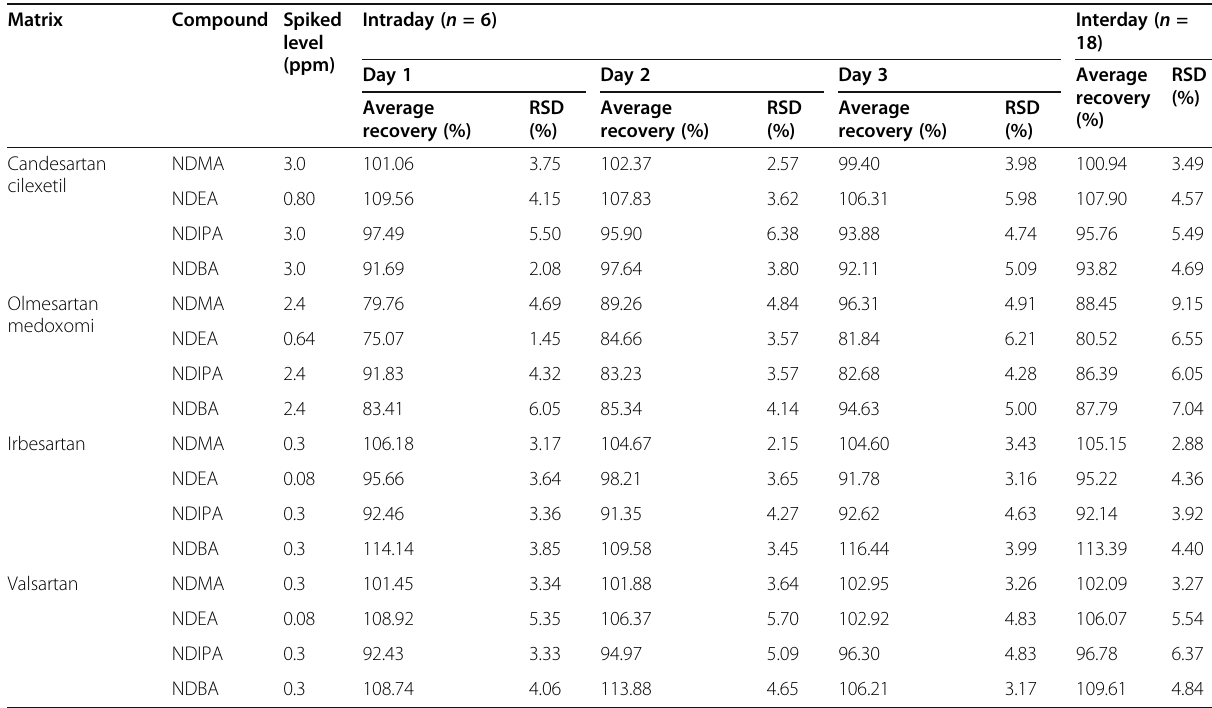
Table 5 Precision assay results of four N-nitrosamines in sartan substances.